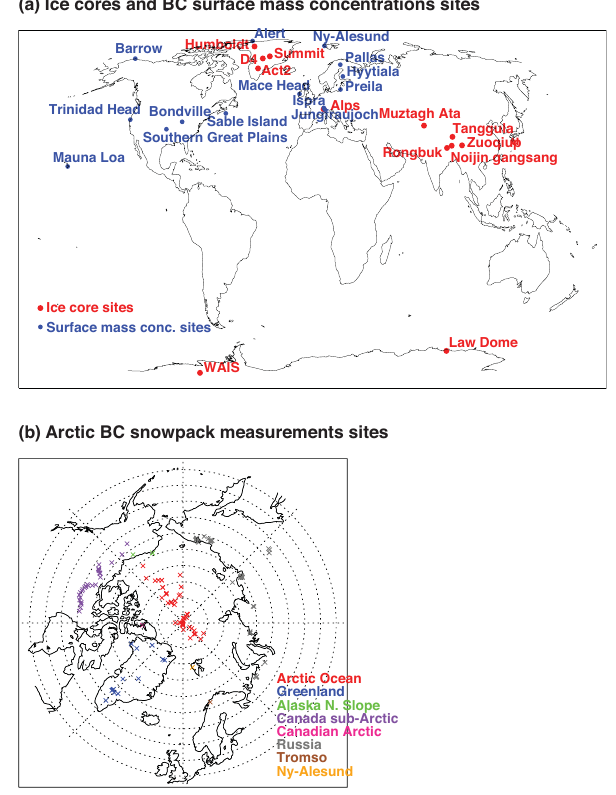
Fig. 6. Geographical locations of (a) ice core sites (listed in Table 7), shown in red, and atmospheric surface mass concentration sites (listed in Table 4), shown in blue, and (b) Arctic BC snow con- centrations sites. Note that Ny- ˚Alesund and Hyyti¨al¨a are shown as Ny-Alesund and Hyytiala,